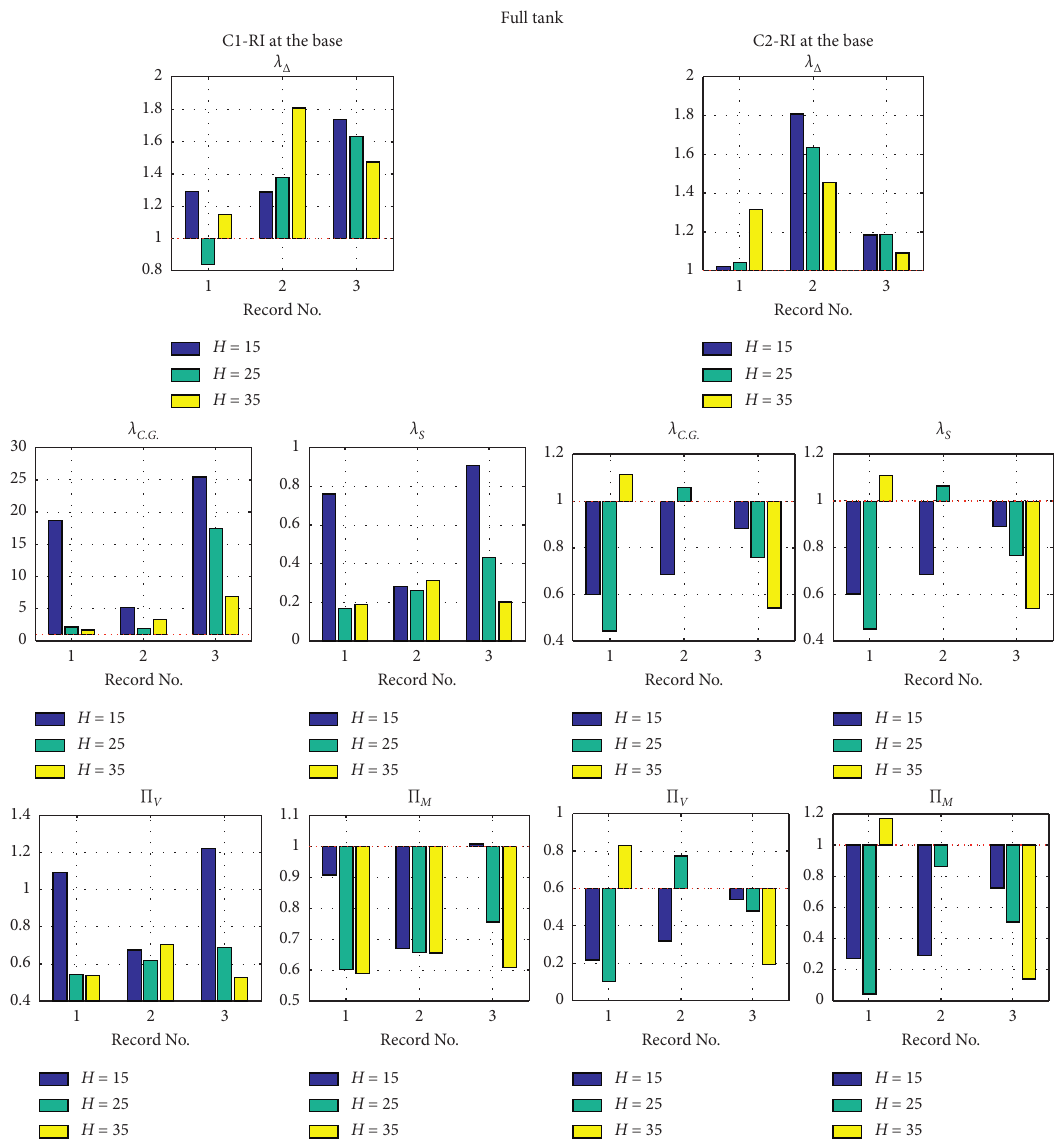
Figure 19: Performance of the prototype structures with “full tank” and various “shaft heights” (15, 25, and 35